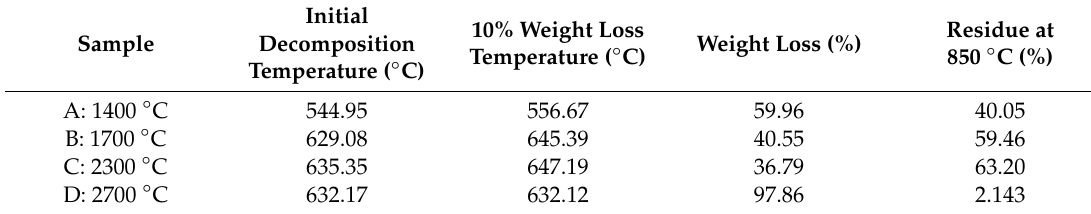
Table 6. Thermogravimetric analysis data of annealed soot.